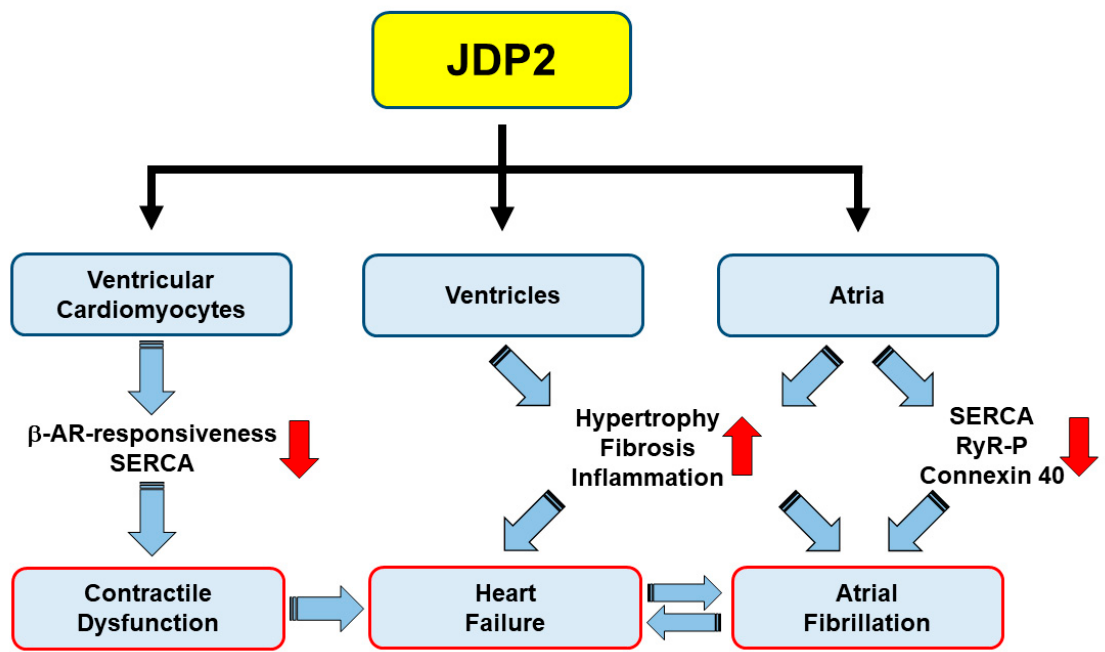
Figure 2. Potential mechanisms contributing to heart failure and atrial fibrillation in JDP2 mice .